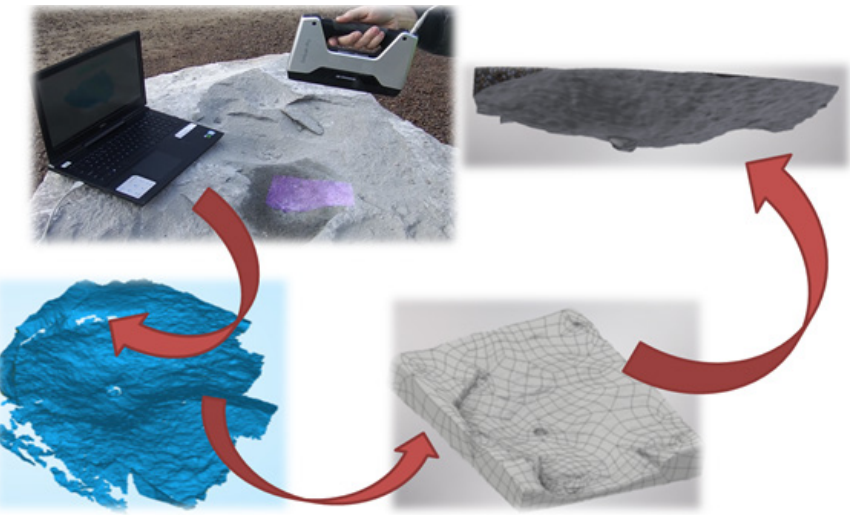
Figure 10: Scheme of processing the scans of rocks surfaces after their loosening.